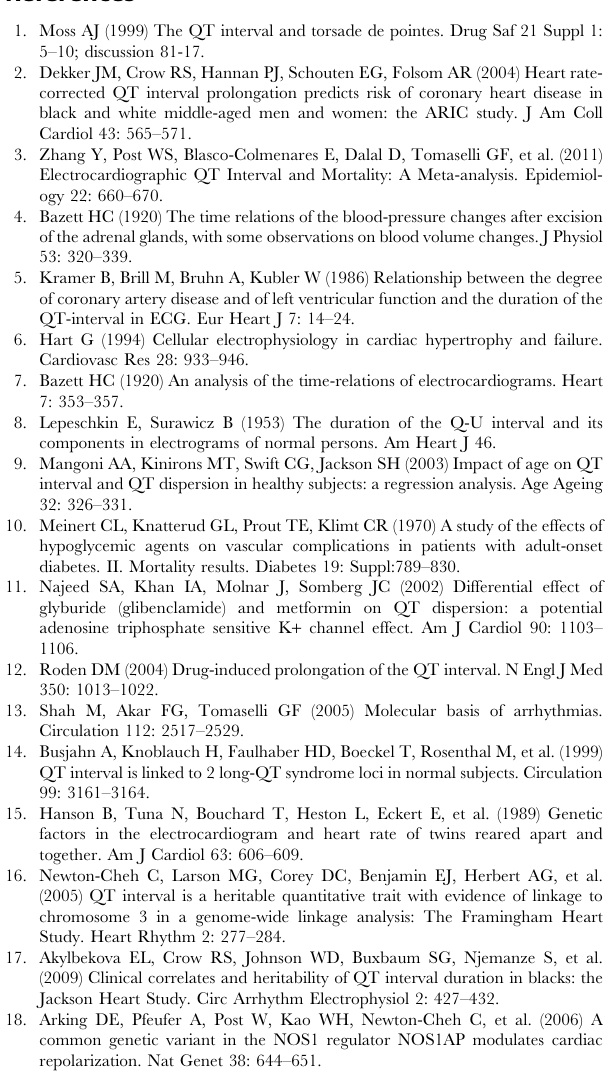
Table S7 QT functional candidates for evaluation after bioinformatic analysis using data from n= 8,644 African American